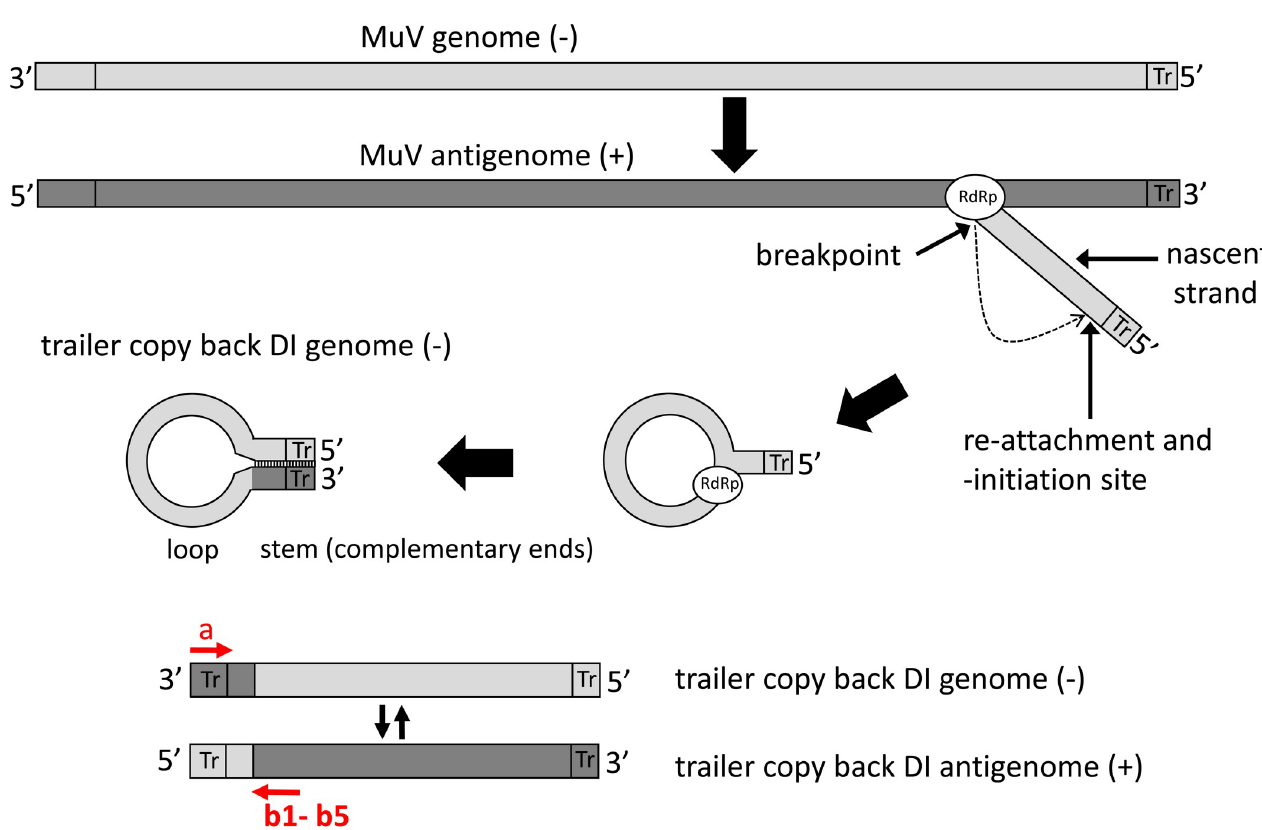
Fig 1. Generation of trailer copy back DVGs during paramyxovirus replication. Trailer copyback DVGs have been proposed to arise during synthesis of the viral genome through detachment of the RNA dependent RNA polymerase (RdRp) from the antigenomic template and switching back to the nascent strand. The positions of detachment from the original template, the breakpoint, and the point of reattachment to the nascent strand, the reinitiation site, are illustrated. Due to the template switching and copying back on the nascent strand the 3’ genomic promoter region has been replaced by a sequence complementary to the 5’ genomic promoter. Copyback DVGs display stem and loop regions of variable length. Mumps virus (MuV) specific DVGs were amplified by RT-PCR using primer a for the reverse transcription reaction and primers a and b1 –b5 for the PCR. The orientation of the primers only allows amplification of DVG- derived sequences, but not from wild-type